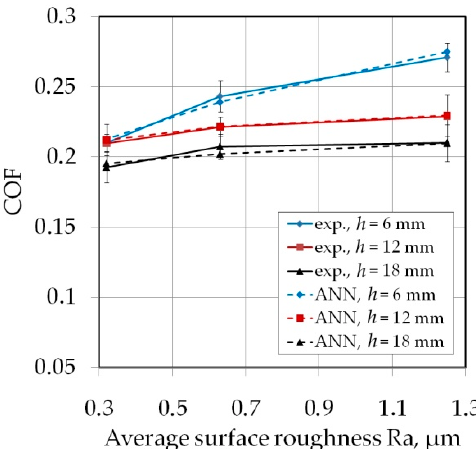
19 of 24 Table 4. Basic regression statistics for training (T) and validation (V) sets. Parameter